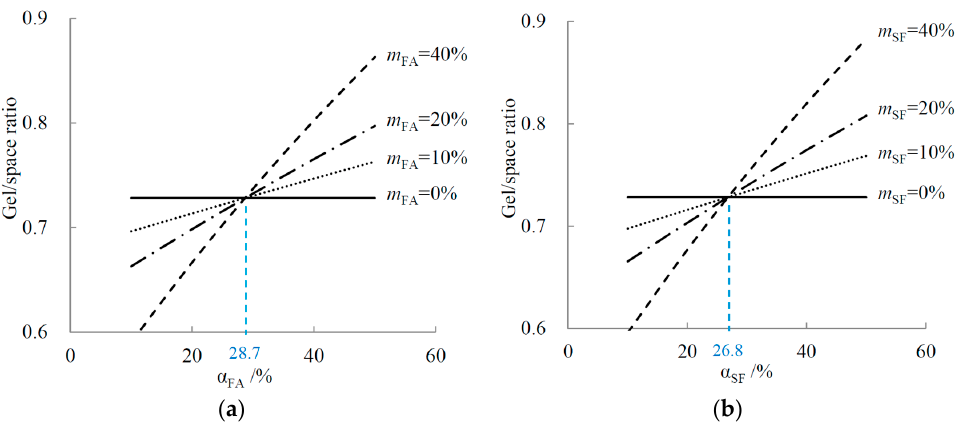
Figure 6. Relationship between gel/space ratio and reaction degree in binary systems: ( a ) FA; and ( b ) SF.